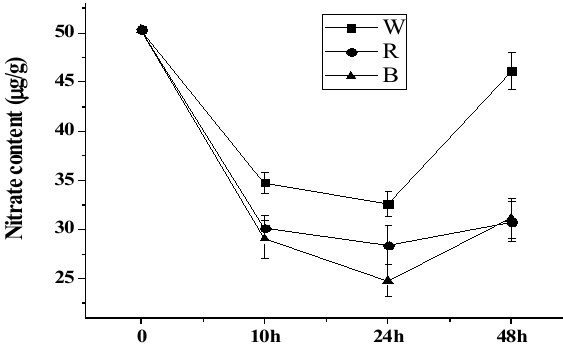
Figure 1: Effects of continuous light on the contents of nitrate in pakchoi.